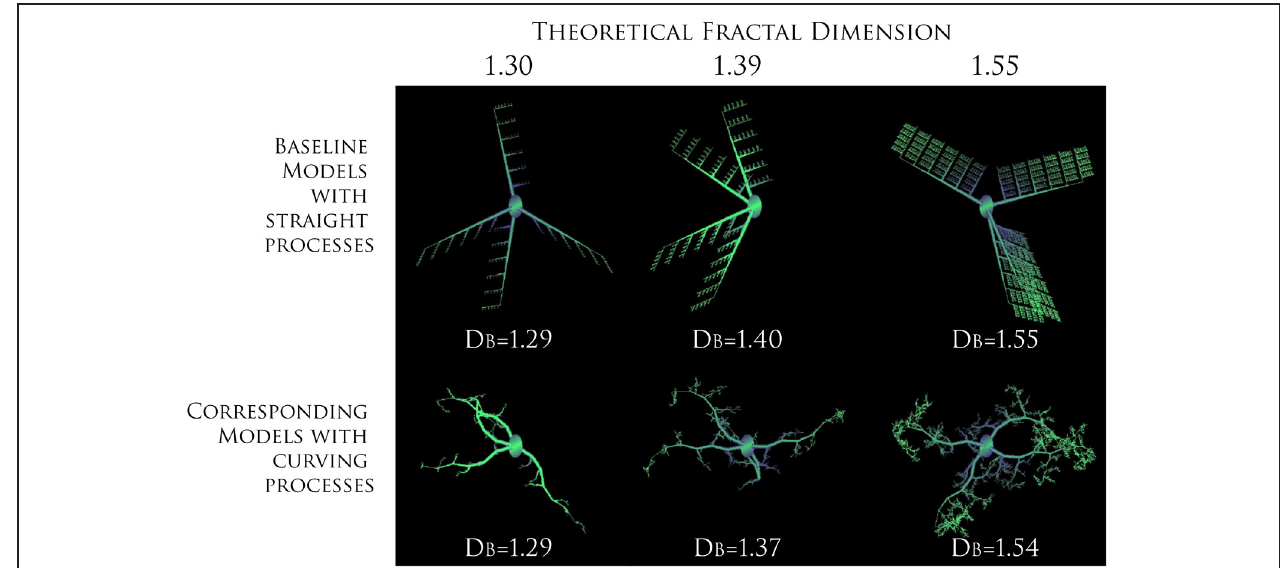
FIGURE 3 | Increasing complexity of branching patterns. Branching structures generated by computer based modeling, according to known rules. At each iteration, the ratio of branch length to parent length was changed to illustrate how branching features influence theoretical D Fs and calculated D B s. For both series, the direction a branch was allowed to grow in